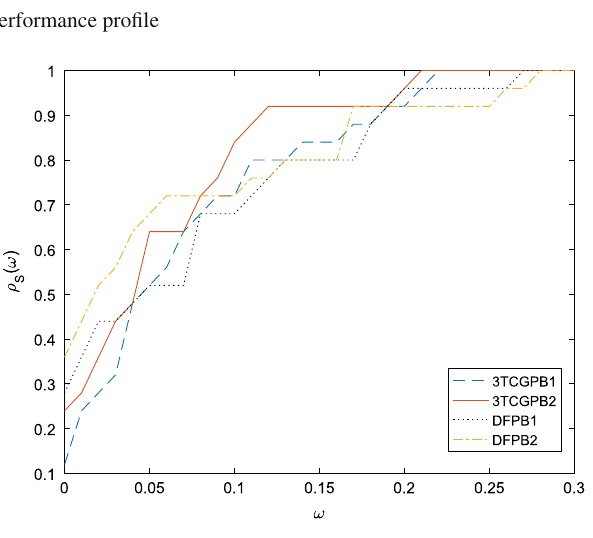
Fig. 3 CPU time performance